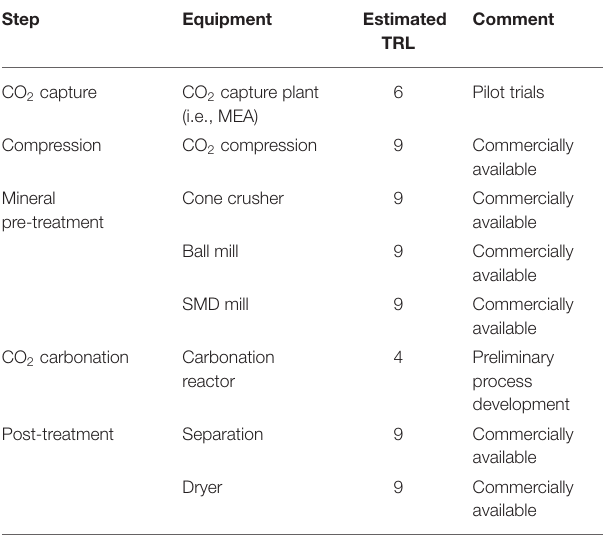
TABLE 1 | TRL definitions of the relevant system